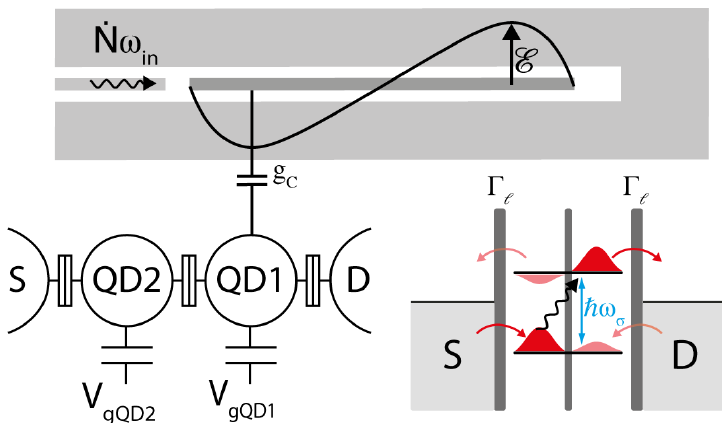
Figure 5. Schematics of the hybrid DQD-resonator circuit. A transmission line with incident photon flux ˙ N ω in is capacitively coupled to a high-quality factor coplanar waveguide resonator that behaves like an ideal quantum harmonic oscillator, with low average photon occupation. The resonator is also capacitively coupled ( g c ) to the DQD. The level spacing of the DQD can be tuned to match the resonator frequency. When a photon is absorbed, the excited electron can tunnel to the drain contact and be detected as a current